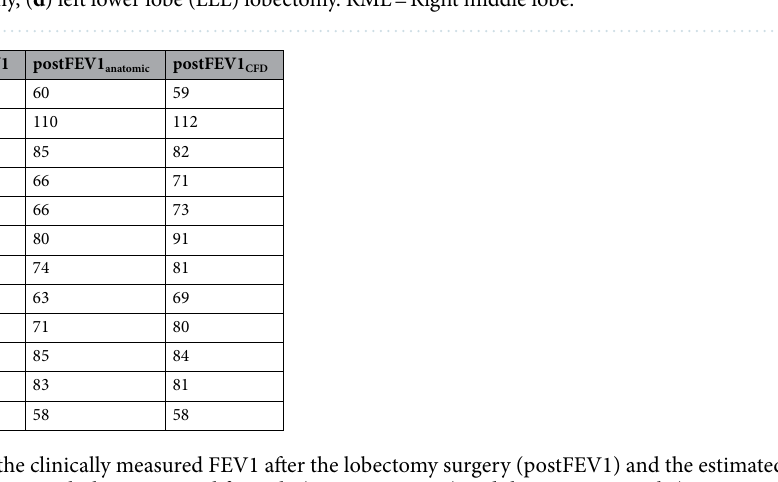
Figure 4. Regional Volume Flow Rate (VFR) in percentage values, estimated through the numerical simulations, for the pre-operative case (white) and the post-operative case (gray) divided according to the lobectomy site . ( a ) right upper lobe (RUL) lobectomies; ( b ) left upper lobe (LUL) lobectomy; ( c ) right lower lobe (RLL) lobectomy, ( d ) left lower lobe (LLL) lobectomy. RML = Right middle lobe.